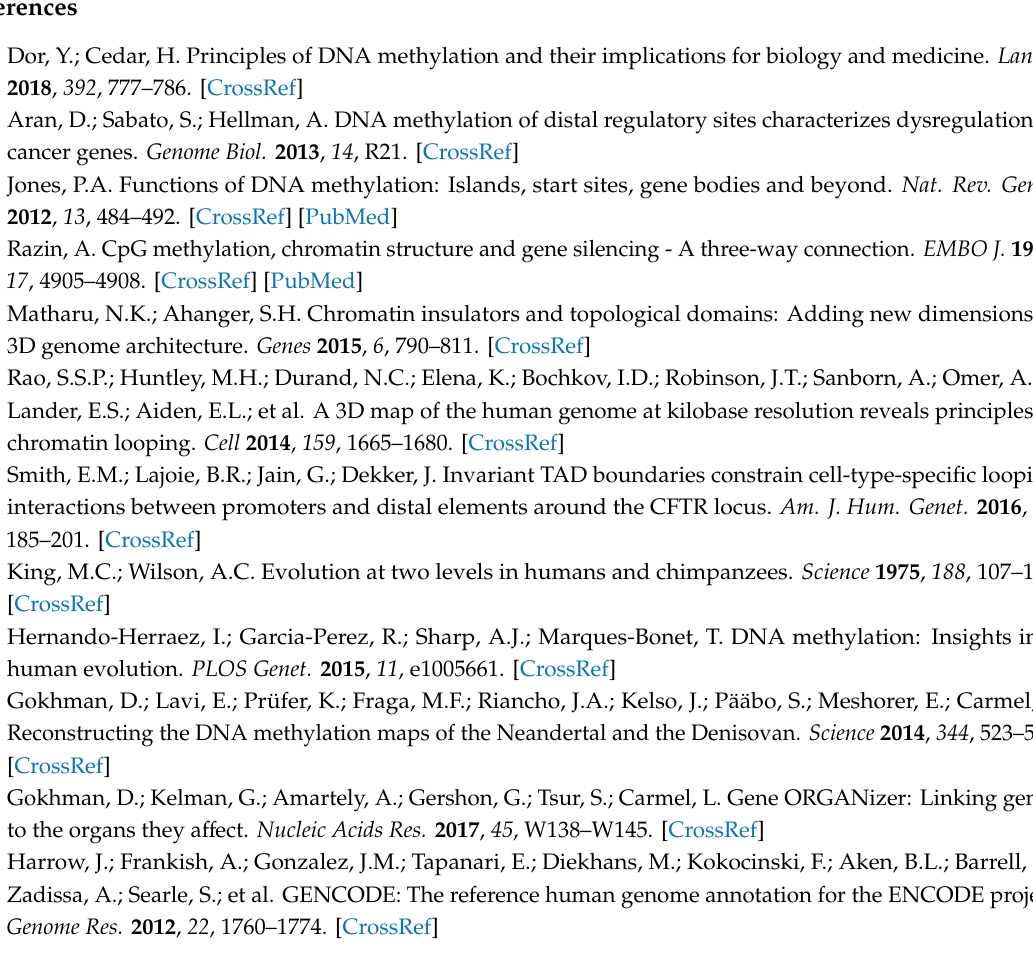
Figure S1: A heat map representing the level of enrichment of each anatomical part within the list of old and new DMGs based on union-TADs, Table S1: Number and median length of identified TADs in four di ff erent cell types, Table S2: MH-derived DMRs tend to reside inside TADs, Table S3: MH-derived DMRs tend to reside close to TAD